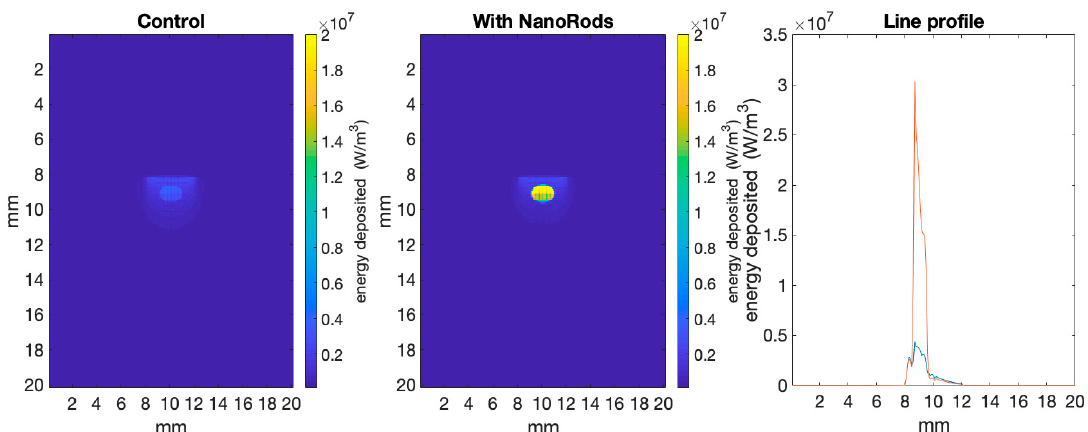
Figure 2. Shows energy deposited per voxel in a 2D slice through the simulations from ARCTORUS, comparing the control to tumour tissue infused with gold nanorods. The line profile bisects the model from top to bottom at 10 mm. The scattering and absorbance values used in the simulations are shown in Table 1.